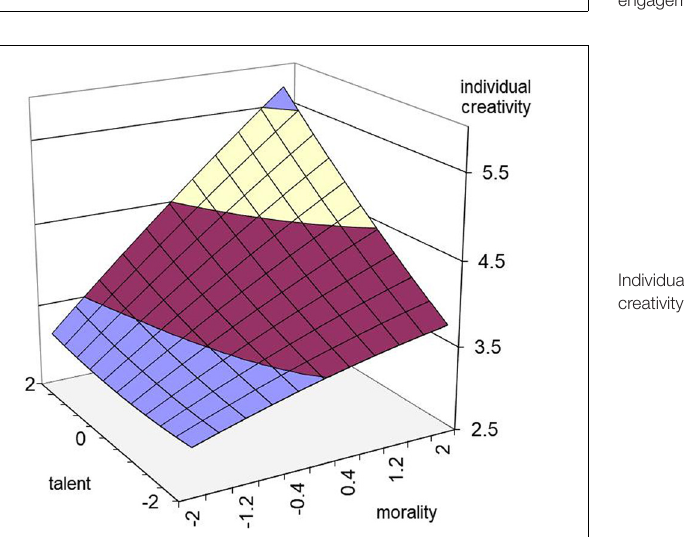
FIGURE 1 | Effects of morality and talent on work engagement.